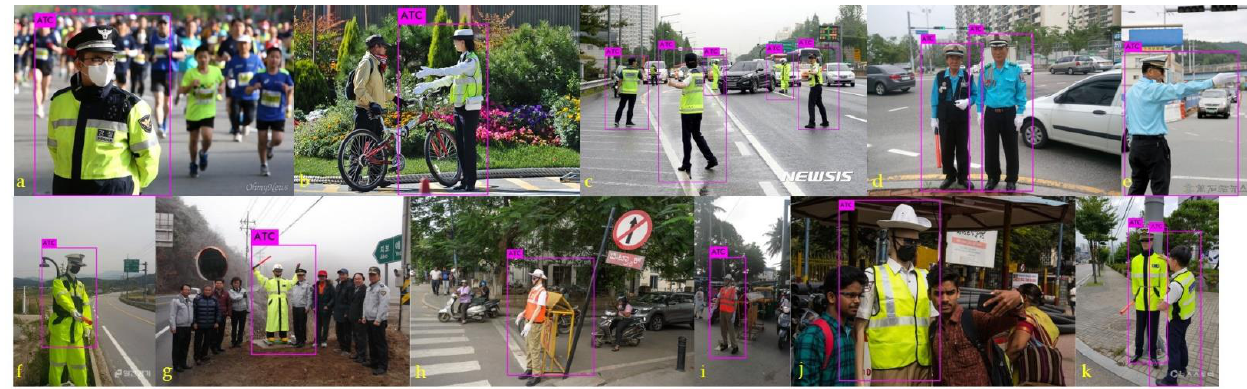
Figure 8. Different scenes ( a – e ) show detections of ATCs through the proposed approach. Special cases are shown from ( f – k ).